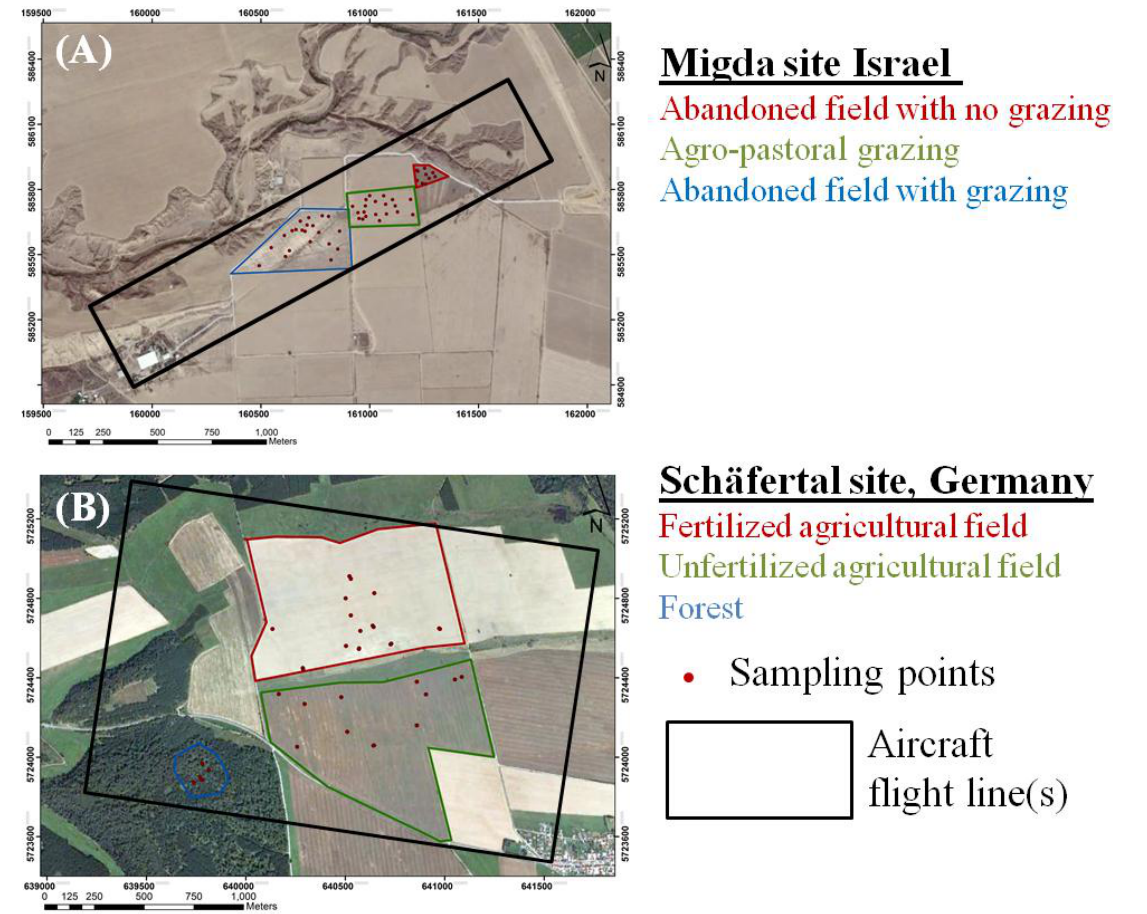
Figure 1. Aerial photograph of the study areas with their land-use categories: ( A ) Migda site, Israel; and ( B ) Schäfertal site,